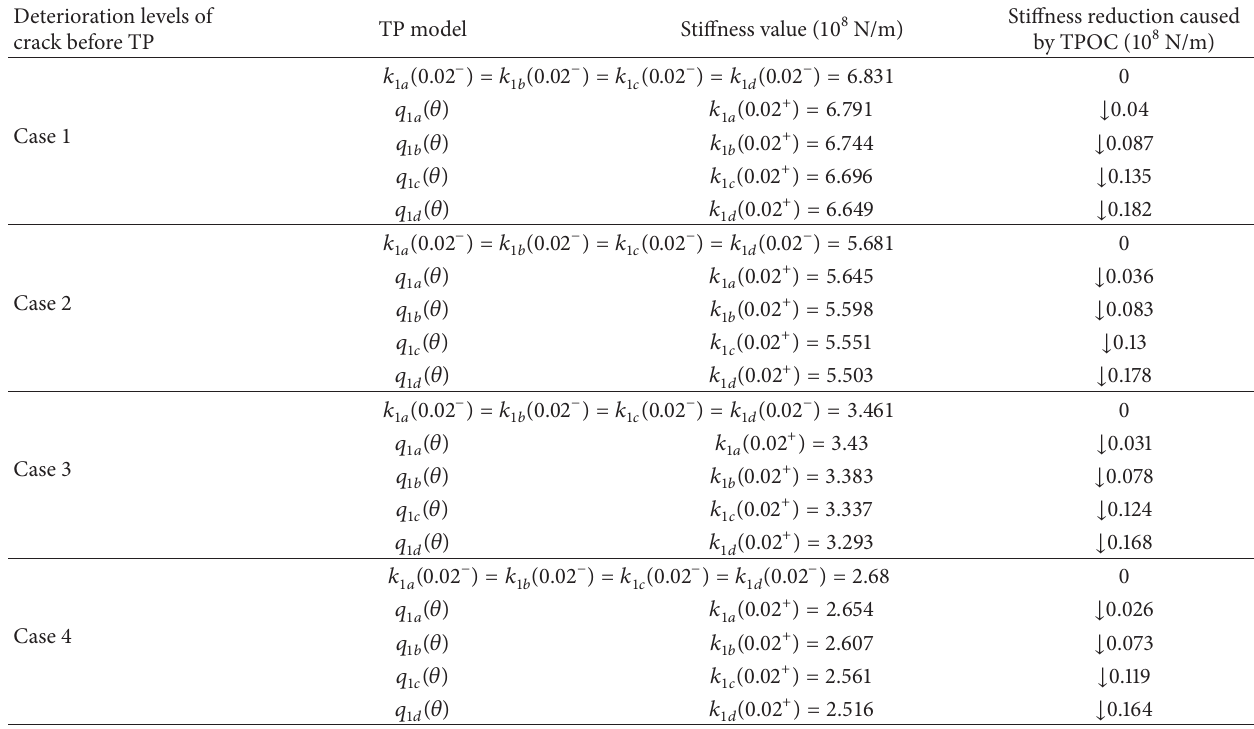
Table 4: Mesh stiffness reduction caused by TPOC (with the model of step function but different lengths) in different deterioration levels. Deterioration levels of